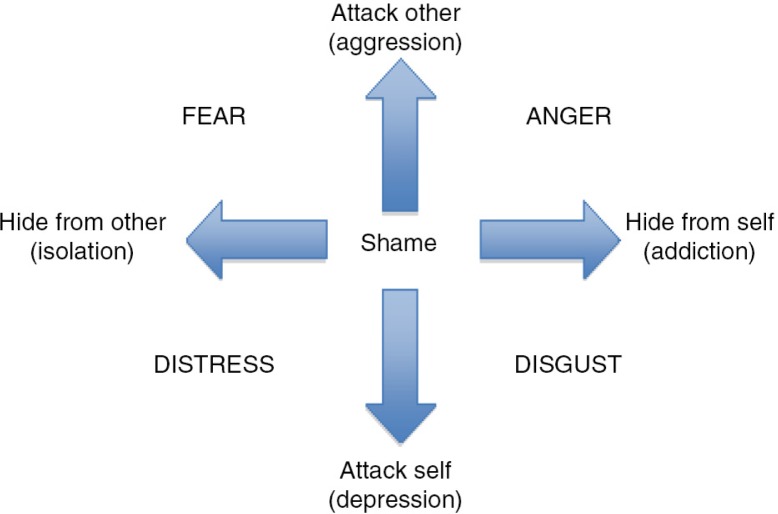
Compass of shame-avoidant behaviours and masking emotions (Webb, 2010, developed from Nathanson, 1992).